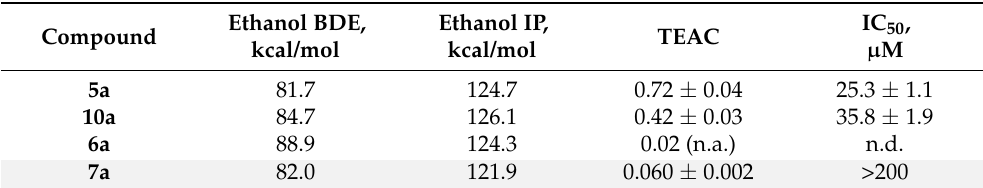
Table 4. Comparison of calculated BDE and IP with AO activity (ABTS: TEAC and IC 50 ) for selected